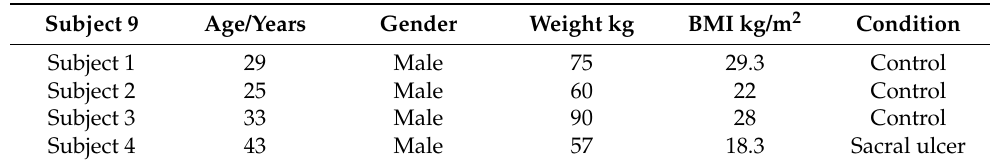
Table 2. Volunteers’ specifications.